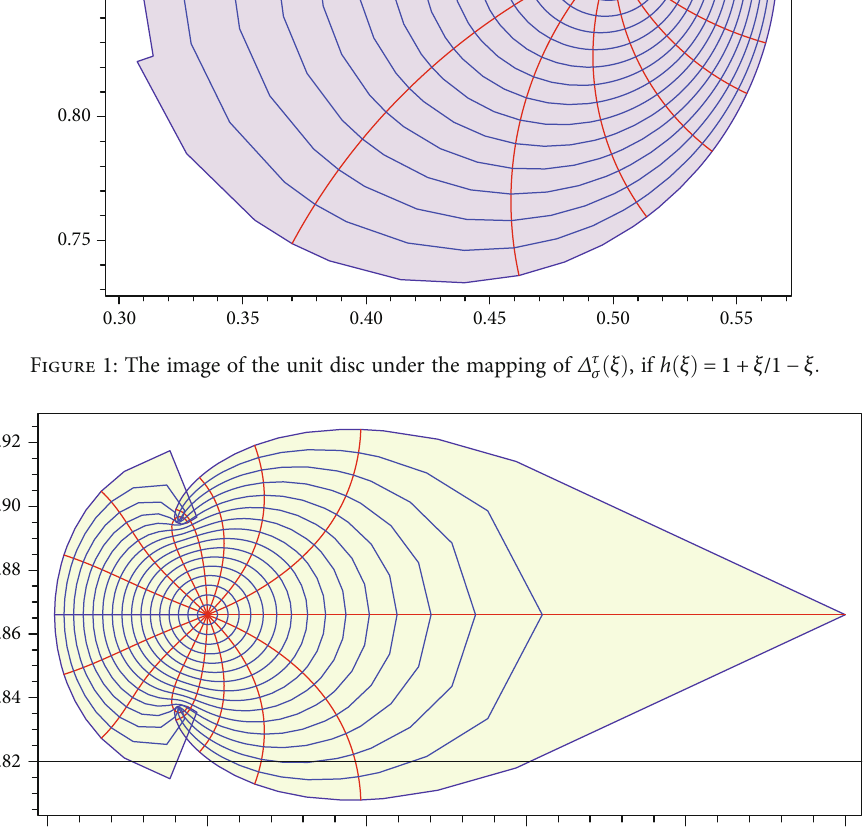
ffiffiffiffiffiffiffiffiffiffiffiffi p 1 + ξ 3 3